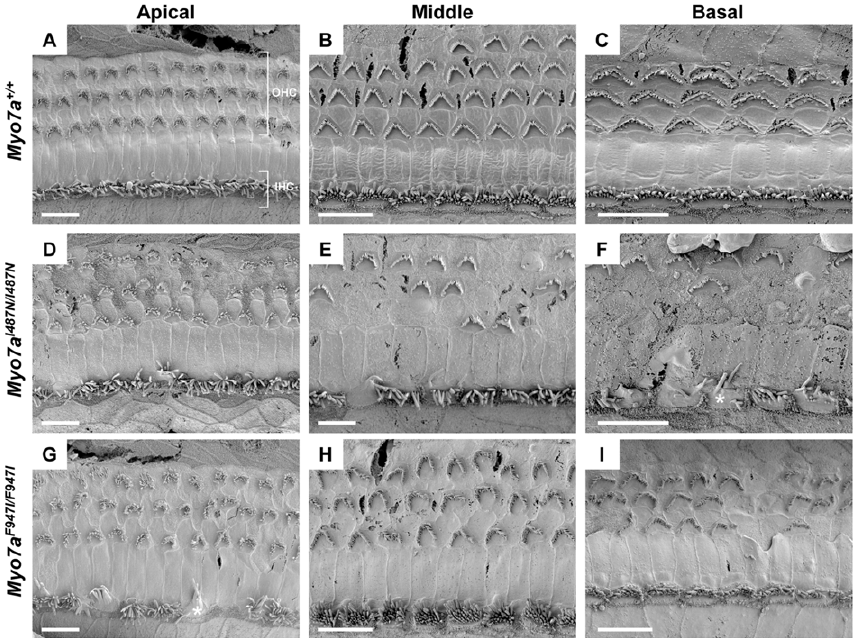
Figure 5. Scanning electron micrographs of cochlear sensory epithelium from Myo7a mutant strains at 8 weeks old. ( A–C ) Myo7a + / + , ( D–F ) Myo7a I487N/I487N ewaso and ( G–I ) Myo7a F947I/F947I dumbo mice at the apical, middle and basal cochlear level. Signs of degeneration and/or mis- orientation of OHC bundles is evident in both Myo7a I487N/I487N ewaso ( D–F ) and Myo7a F947I/F947I dumbo ( G–I ) mice at all levels of the cochlea. This appears to be more severe in Myo7a I487N/I487N ewaso mutants, where many bundles are missing in the mid and basal regions ( E and F ). IHC bundles are also affected, appearing disorganised and/or showing signs of fusion in the basal levels of Myo7a I487N/I487N ewaso cochleae (asterisk in F), and conversely in the apical region of Myo7a F947I/F947I dumbo mutants (asterisk in G). Scale bar; 10 m M